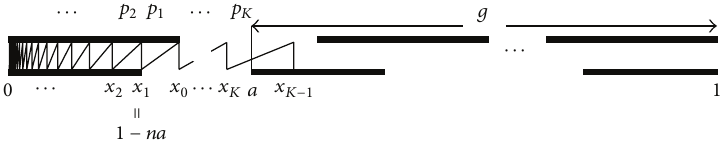
Figure 18: Construction scheme for density 𝑝(𝑥) in the case of arbitrary 𝑛 ≥ 2